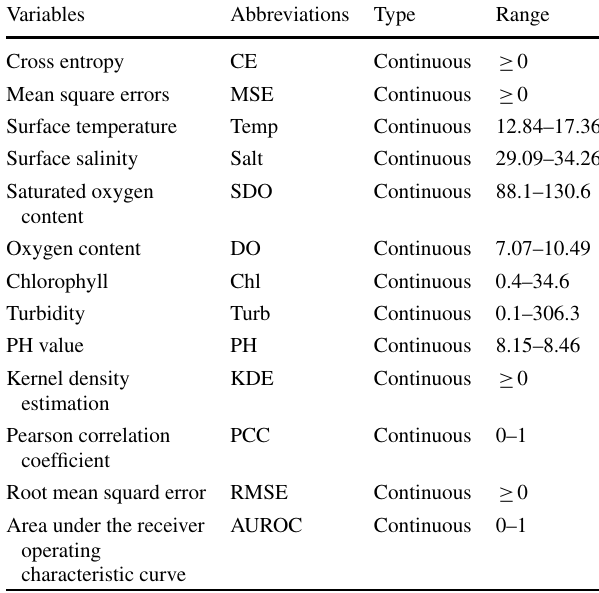
Table 2 List of variables and abbreviations mentioned in the